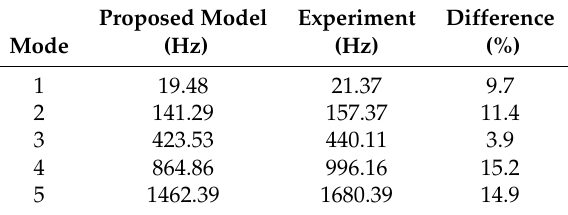
Table 7. Pinned at a = 150 mm and m attached